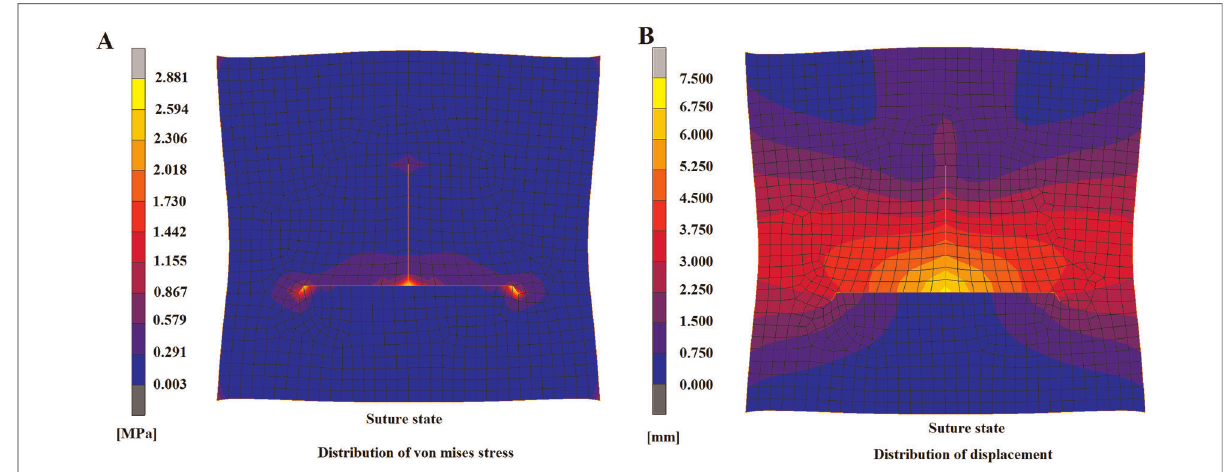
FIGURE 6 A-T fl ap at suturing state. ( A ) Distribution of von mises stress. ( B ) Distribution of